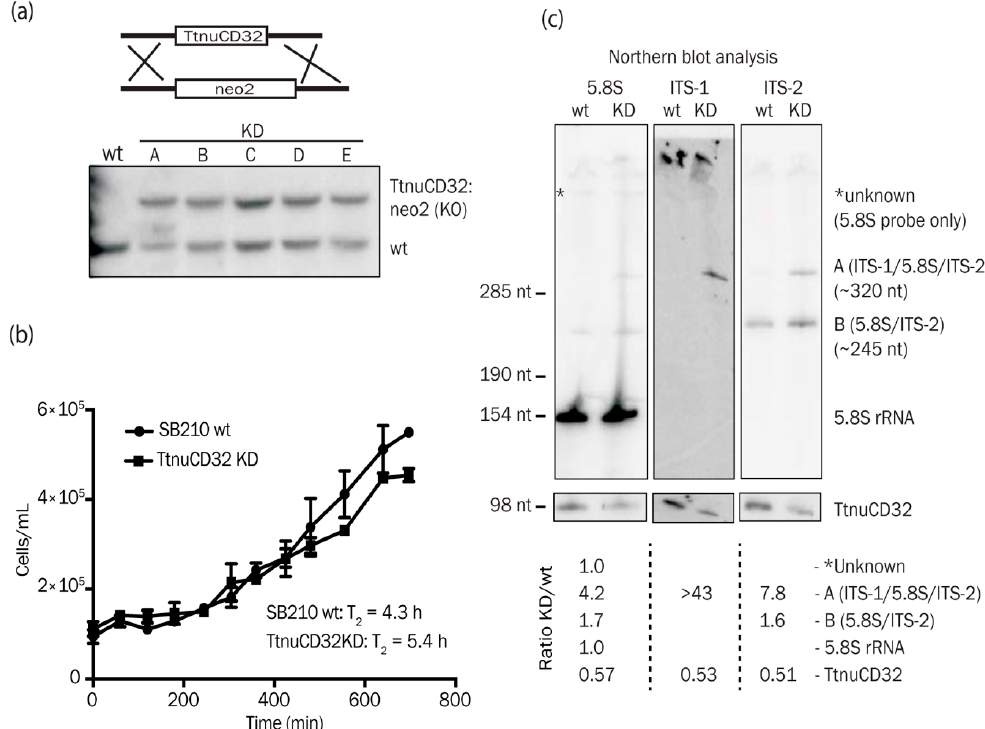
Figure 3. TtnuCD32 knock-down affects 5.8S rRNA maturation: ( a ) Upper part: Schematic illustration of the targeted substitution of the endogenous TtnuCD32 locus with the neo2 paromomycin resistance cassette. Lower part: Southern blot analysis demonstrating the partial replacement of the wild-type (wt) TtnuCD32 copies with the neo2 cassette in 5 mutant strains (A–E) creating the TtnuCD32 KD strains; ( b ) The growth curves averaged from two independent TtnuCD32 knock-down (KD) cell lines compared to two control cell lines. The doubling times (T 2 ) for each cell type derived from the best fitted curve are given within the graph area. An Extra sum-of-squares F -test supported different growth curves as the best model to explain the datasets ( p < 0.0001); ( c ) Northern blot analysis of the small molecular weight components of pre-rRNA processing in wild-type (wt) vs. TtnuCD32 KD cell lines (KD). Probes specific for 5.8S rRNA, ITS-1, ITS-2, and TtnuCD32 were applied as noted above the images. Sizes of the accumulating pre-5.8S species A and B was calculated based on the size/mobility relation of known RNAs visible by EtBr staining or northern blot analysis. Signals from the northern blot analysis were quantified and ratios KD/wt for rRNA species present on each panel are given below the images.